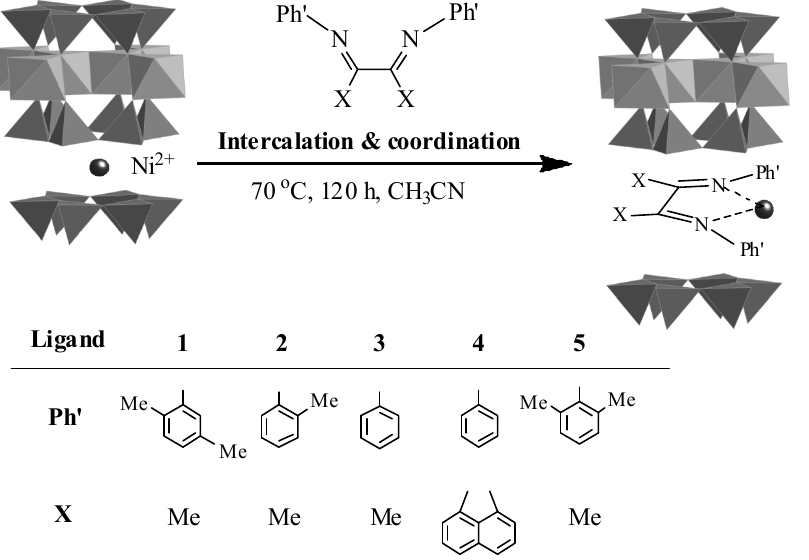
Figure 1. Proposed feature of α -diiminenickel complex immobilized in fluorotetrasilicic mica interlayer.